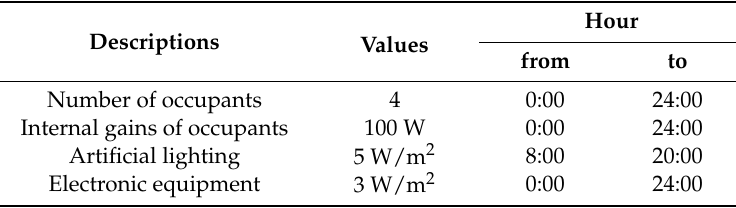
Table 5. Boundary